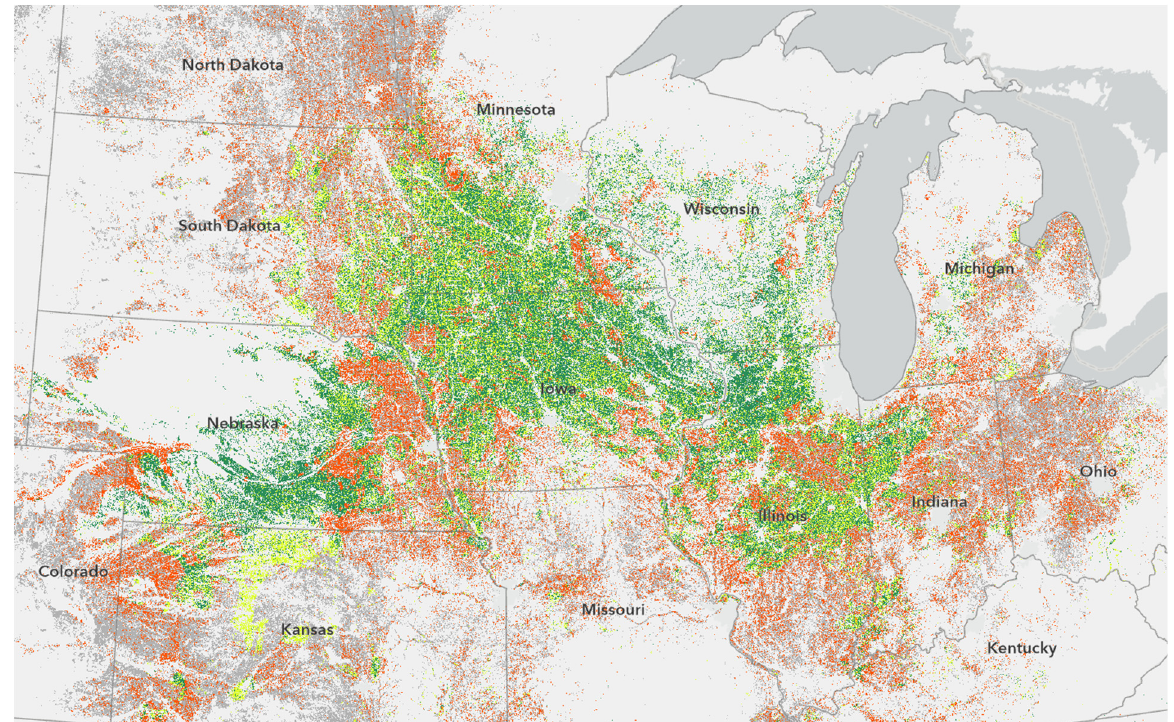
Figure 5. Random Forest corn suitability compared with real-world presence/absence data. Areas in green represent suitable presence (true positive); areas in yellow represent suitable absence (false positive); areas in orange represent unsuitable presence (false negative); areas in grey represent unsuitable absence (true negative). RF shows clearly poorly defined areas of suitability with little yellow (false positive), suggesting overfit.